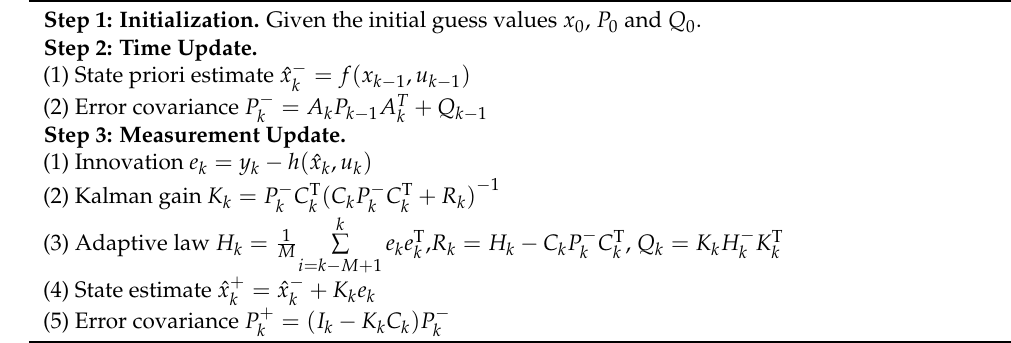
Table 5. Summary of the AEKF-based co-estimation